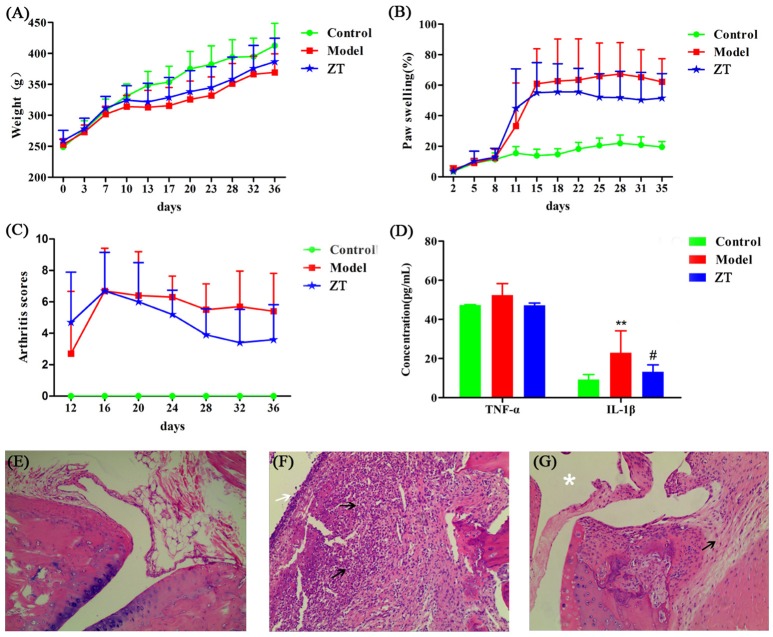
Evaluation of CIA model construction and efficacy of ZT. (A) Body weight, (B) paw swelling, (C) arthritis score, and (D) serum levels of inflammatory factors TNF-α and IL-1β. All the above values are expressed as Mean±SD (n = 10), **, vs. Control, P < 0.01; #, vs. Model, P < 0.05. Representative photographs of histological examination of synovial tissues in the ankle joint (100 × magnification). (E) Control group, (F) model group, (G) ZT group. The black arrows indicate numbers of inflammatory cells, such as plasma cells, lymphocytes, and neutrophils, the white arrow indicate destoryed cartilage. The asterisks indicate clear joint cavity.